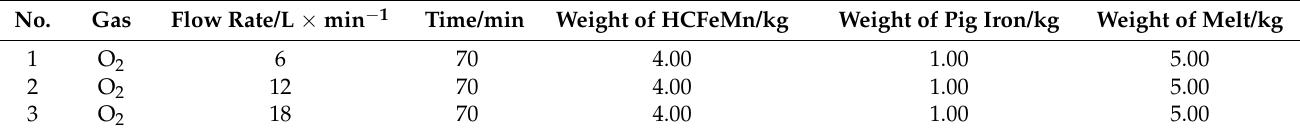
Table 2. The scheme for preliminary experiments.